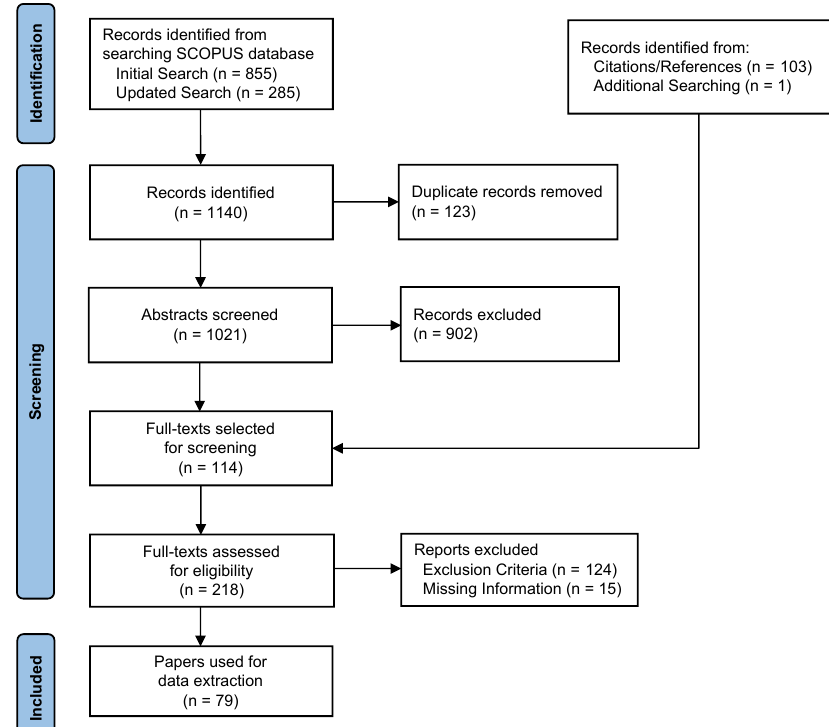
Figure 1. Flow of sources of literature through the paper screening